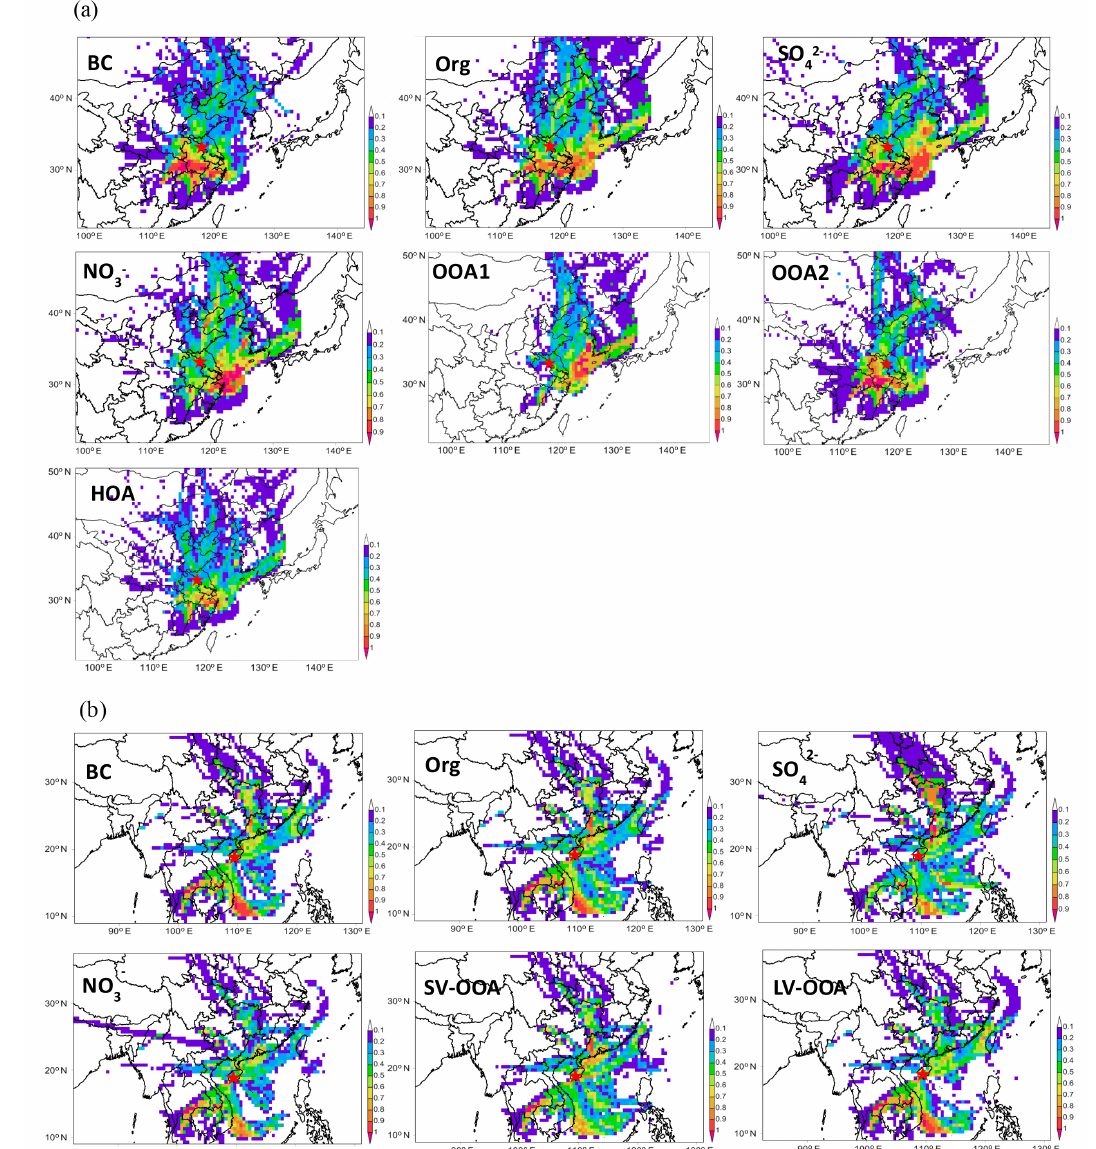
Figure 7. Mapping of the TPSCF results of major aerosol species at (a) NCB and (b)